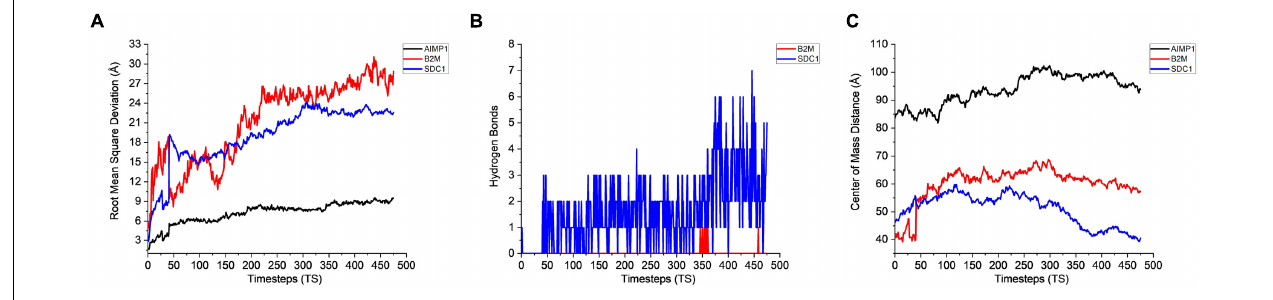
FIGURE 5 | Stability analysis for the interactions between CHO extracellular proteins and AMB-1 surface proteins. (A) Root mean square deviation (RMSD), (B) hydrogen bonds, and (C) center of mass (1 TS = 105 ps).